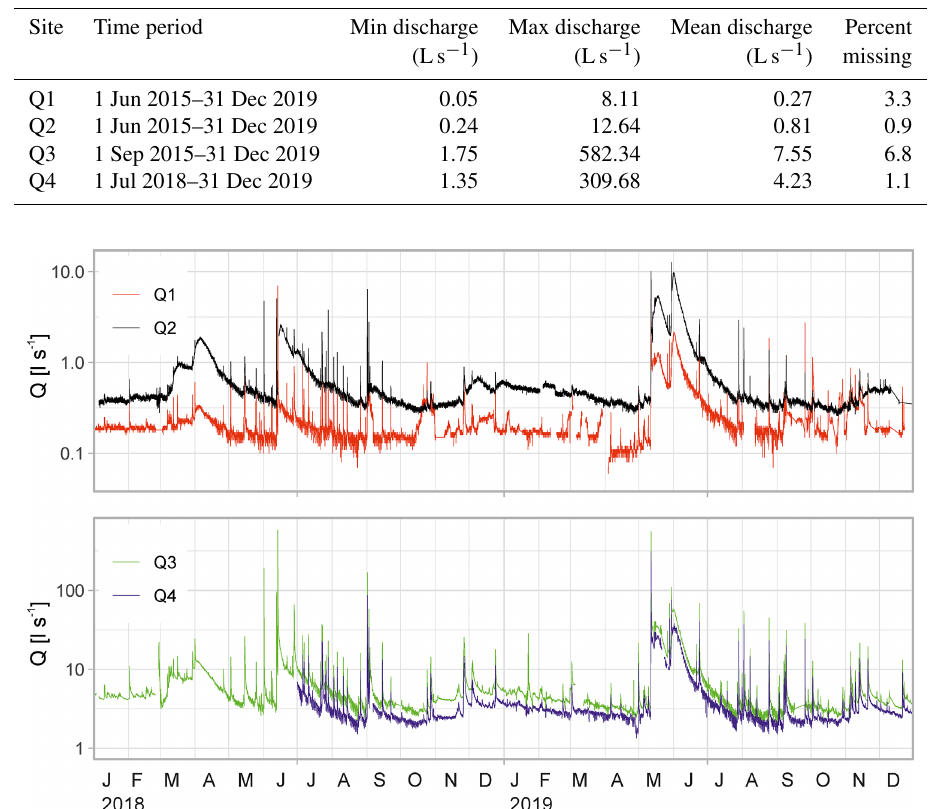
Figure 6. Discharge hydrographs at gauges Q1 to Q4 for the years 2018–2019 ( Q in log scale).